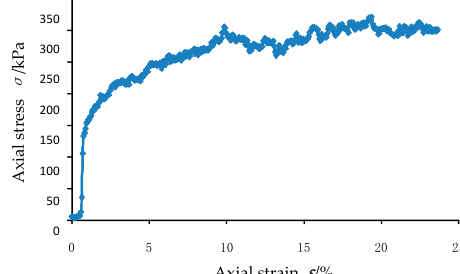
Figure 12. Axial stress-strain curve of the DEM analysis for triaxial test.